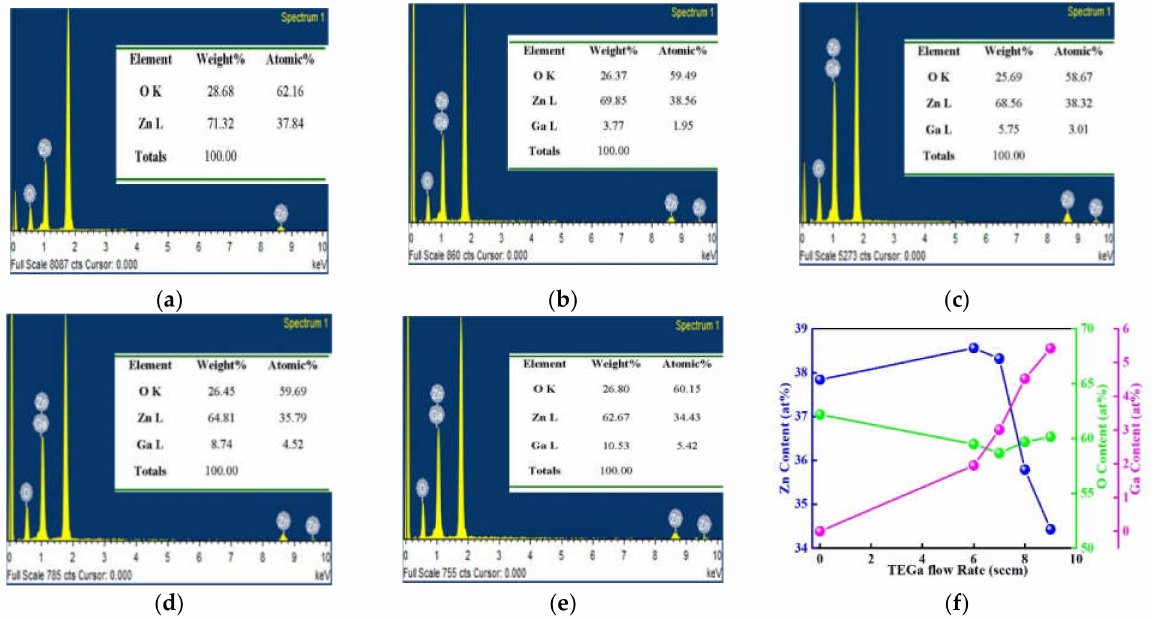
Figure 3. The EDX spectra of ( a ) ZnO and MIPEMOCVD-grown GZO thin films with Ga contents of ( b ) 1.95, ( c ) 3.01, ( d ) 4.52, and ( e ) 5.42 at%. ( f ) summary of Zn, O, and Ga content of ZnO and MIPEMOCVD-grown GZO with varying TEGa flow